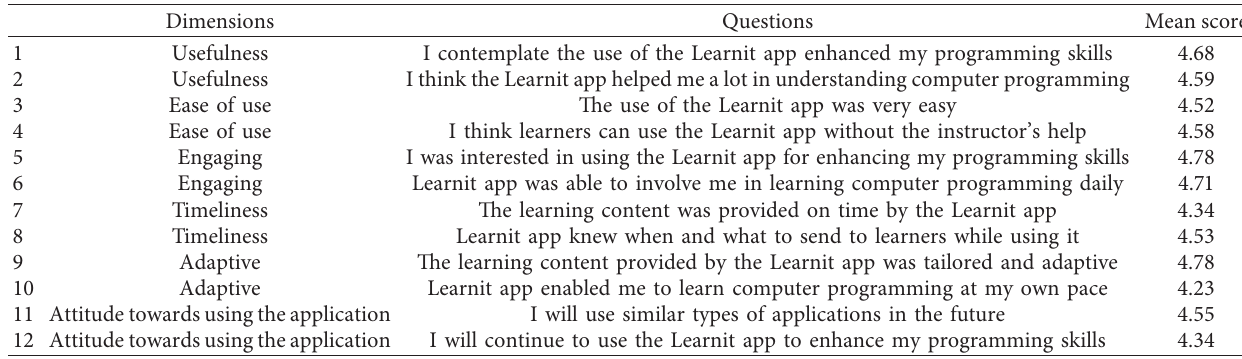
Table 7: End-user computing satisfaction (EUCS) questionnaire result.